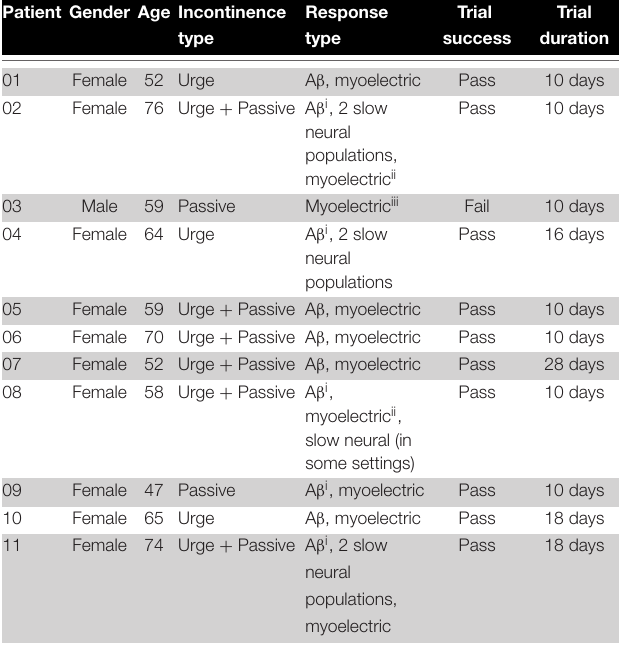
TABLE 2 | Symptoms and responses observed in each